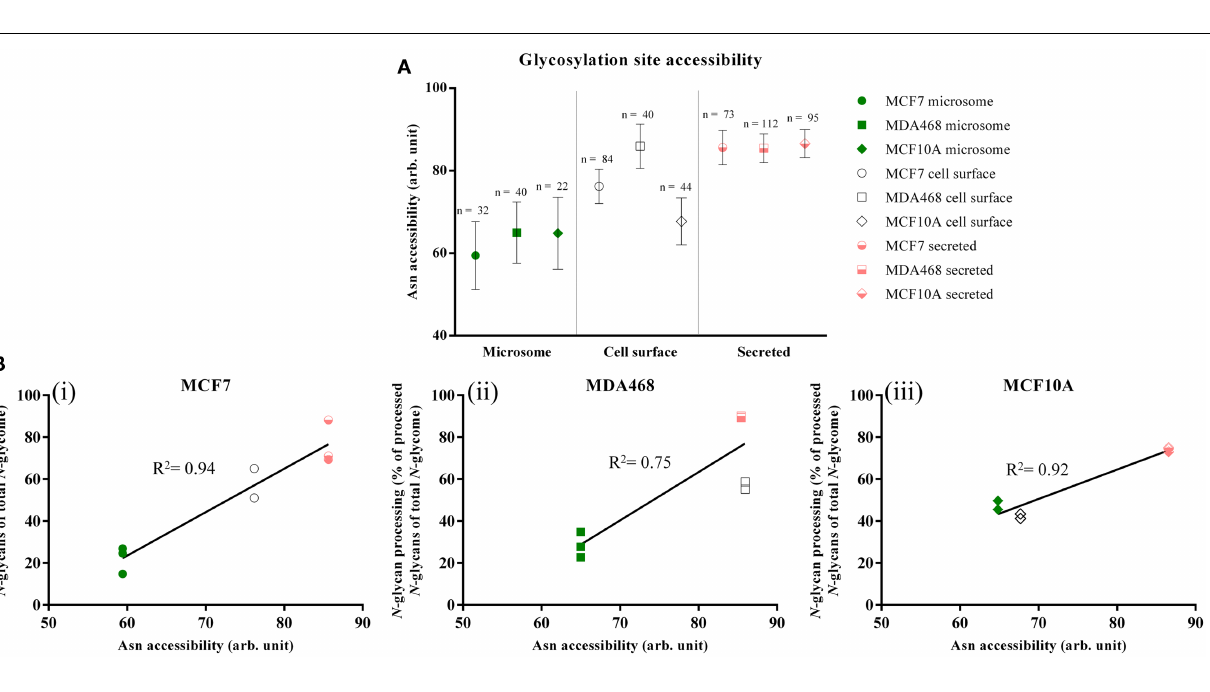
FIGURE 3 | (A) Glycosylation site accessibilities (unit-less, arbitrary values, mean ± SEM) of the microsomal (green), cell-surface (white), and secreted (light red) proteins derived from MCF7, MDA468, and MCF10A breast epithelial cell lines. (B) Correlation between the site accessibilities and the